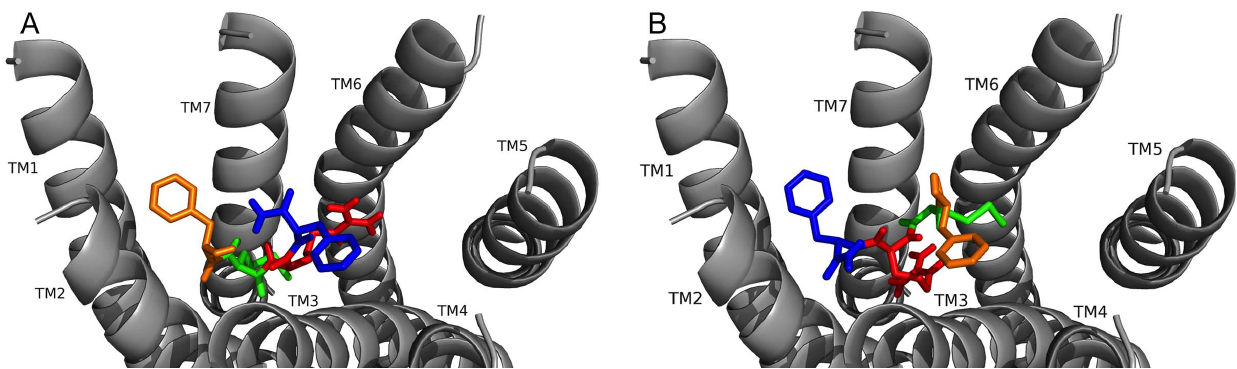
Figure 3. FMRF-NH 2 docked to FMRFa-R yielded two best poses. Two best poses (A and B) were generated in docking FMRF-NH 2 to FMRFa-R. Contacts made between the amino acids in FMRF-NH 2 are shown as F1 (orange), M (green), R (red), and F4 (blue) and the receptor, FMRFa-R, whose